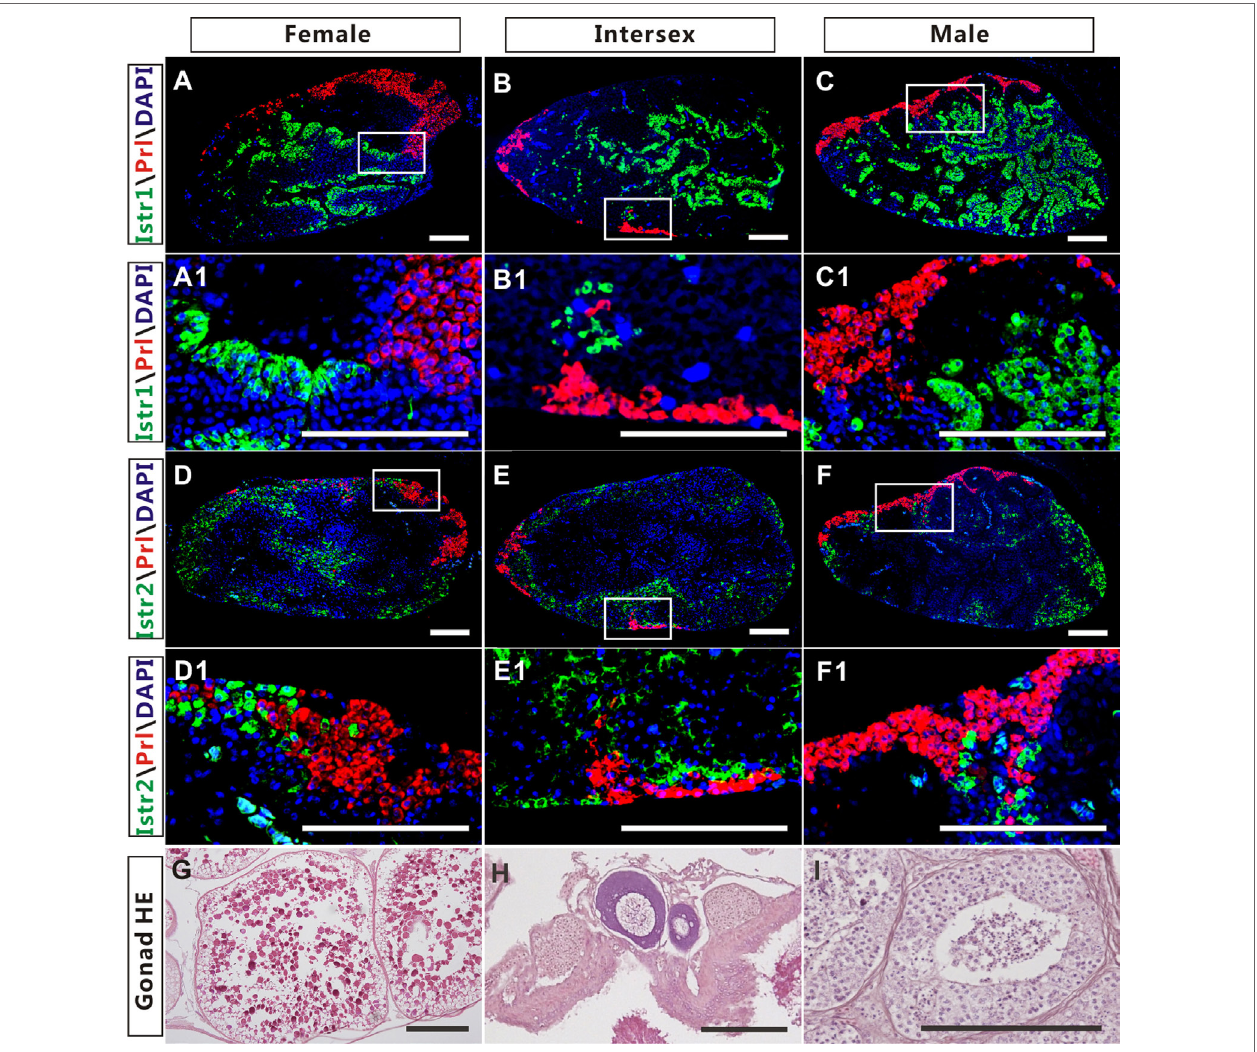
FigUre 6 | The cellular localization of immunoreactive isotocin (Ist) receptor 1 (Istr1) (green), Istr2 (green), and prolactin (Prl) (red) in the pituitary of female, intersexual, and male ricefield eels. The rabbit antiserum against Istr1 (1:500) or Istr2 (1:500) and mouse antiserum against Prl (1:800) were used as primary antisera. The secondary antibodies were Alexa Fluor 488-labeled goat anti-rabbit immunoglobulin G (H + L) for Istr1 and Istr2, and Cy3-labeled goat anti-mouse lgG (H + L) for Prl. DAPI was used to stain the nuclei blue. Sagittal sections of ricefield eel pituitaries were shown here with the rostral (anterior) to the left. (a1–F1) are higher magnification of (a–F) , respectively. (g–i) : HE-stained gonads of the experimental fish at female, intersexual, and male stages, respectively. Scale bar is 50